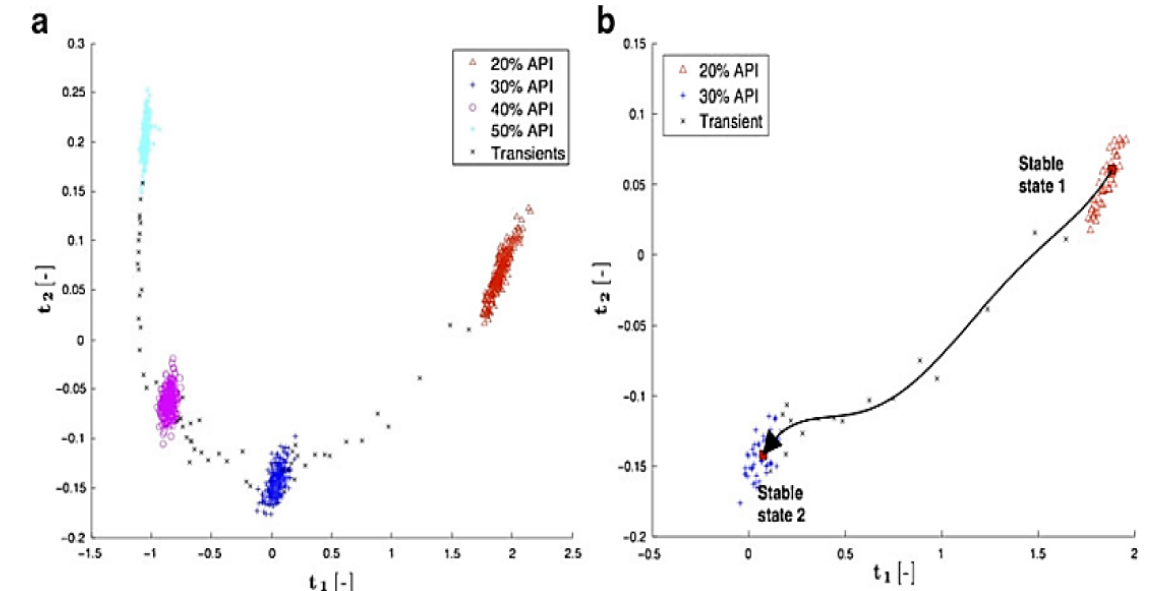
Figure 3. ( a ) Different API concentration with feed rate, ( b ) real-time monitoring to evaluate the time required for the transition from stable state 1 to stable state 2. (Reproduced with permission from Markl, D et al., AAPSPharmSciTech; published by Springer Nature, 2013) [82]